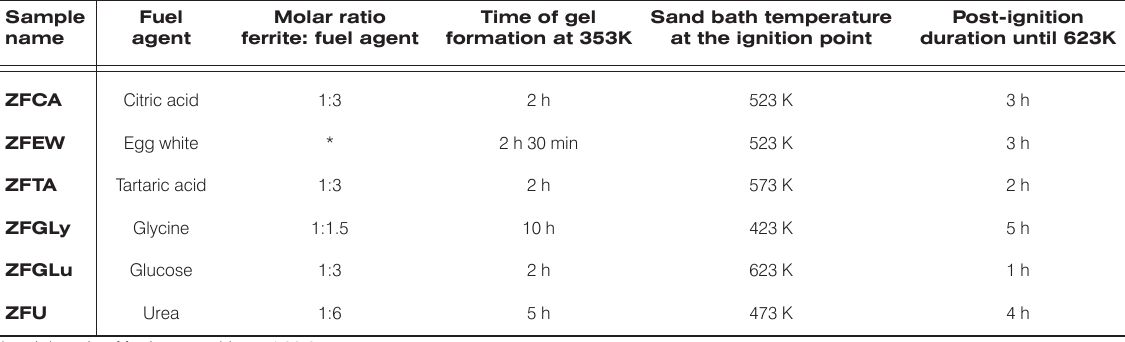
Table 1. Details of protocol synthesis until annealing stages in the